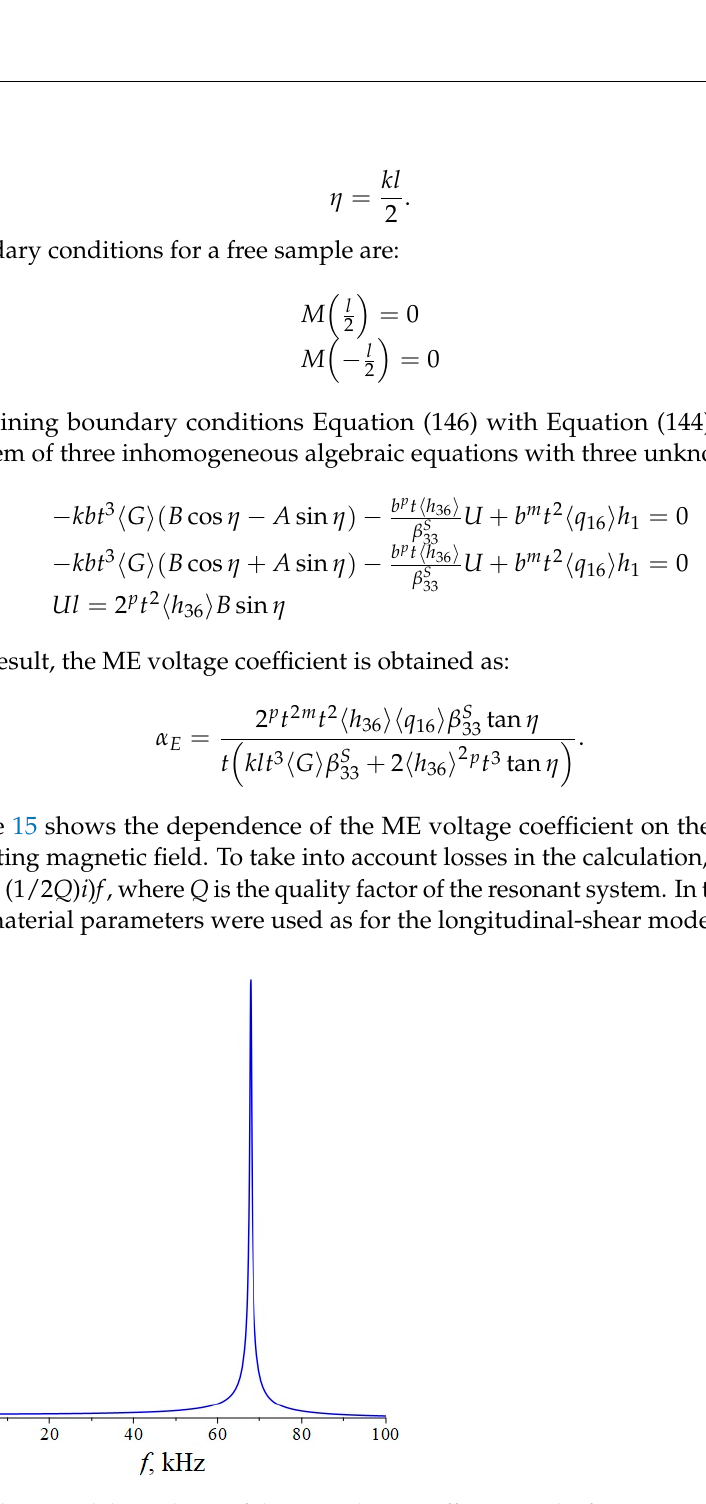
Figure 15. Theoretical dependence of the ME voltage coefficient on the frequency of the alternating magnetic field for ME structure Metglas/GaAs of the torsional mode.